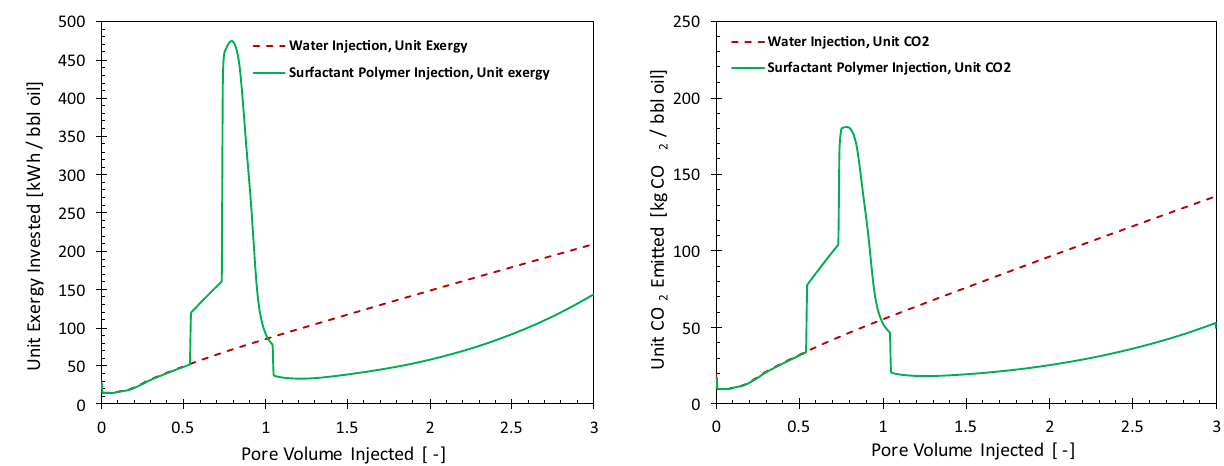
Figure 11. Histories of the unit energy consumed (left) and instantaneous unit CO 2 emitted (right) for water injection (dashed line) and surfactant-polymer injection (solid line)